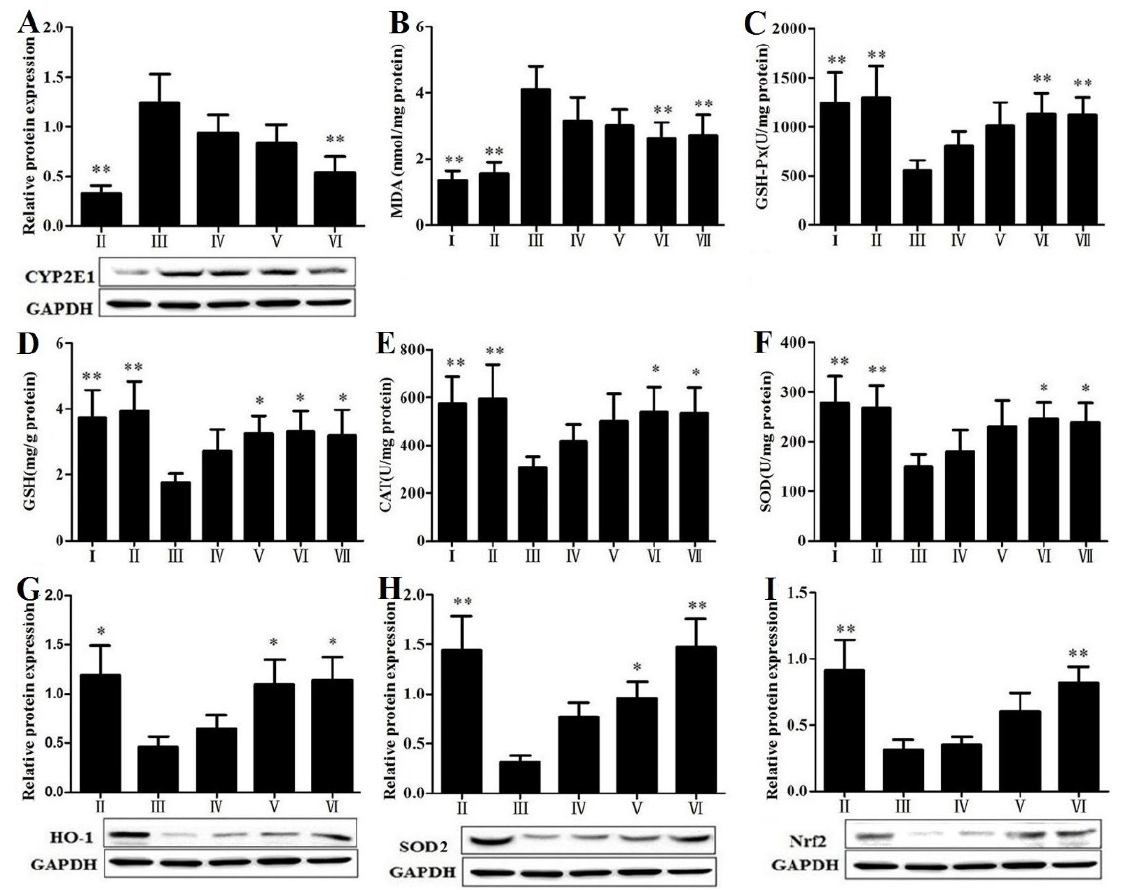
Figure 5. Effect of Rosa laevigata Michx fruit (RLTS) on the protein expression of CYP2E1 ( A ); Effects of RLTS on the levels of MDA, GSH-Px, GSH, CAT and SOD in livers ( B – F ); Effects of RLTS on the protein expressions of HO-1, SOD2 and Nrf2 ( G – I ). ( I ) RLTS control; ( II ) Normal control; ( III ) model; ( IV ) RLTS (70 mg/kg) + CCl 4 ; ( V ) RLTS (140 mg/kg) + CCl 4 ; ( VI ) RLTS (210 mg/kg) + CCl 4 ; ( VII ) silymarin (210 mg/kg) + CCl 4 . Values are expressed as mean ± SD ( n = 4). * p < 0.05; ** p < 0.01 vs. model